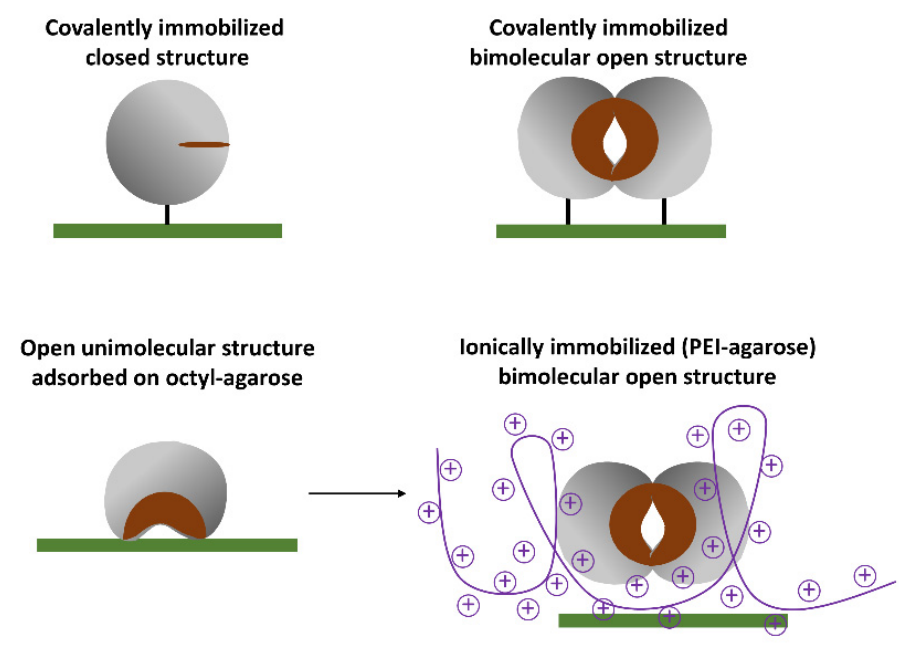
Figure 4. Different derivatives of the immobilized Lecitase.